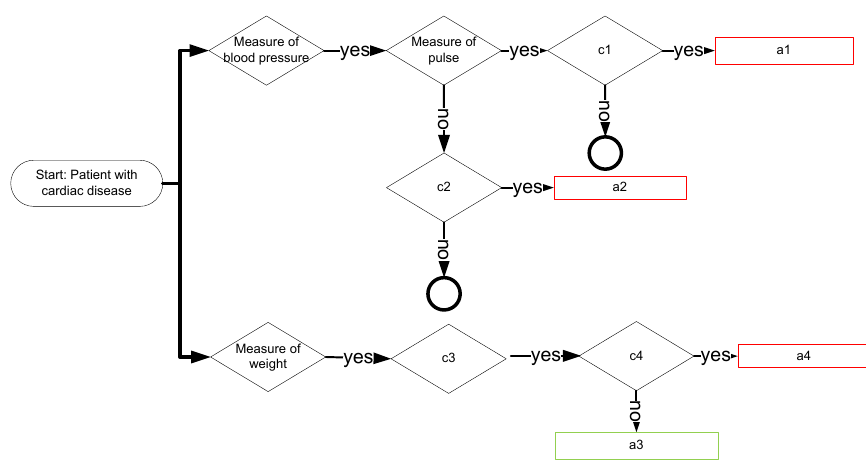
Figure 2. Demand modeling using the Clinical Algorithm